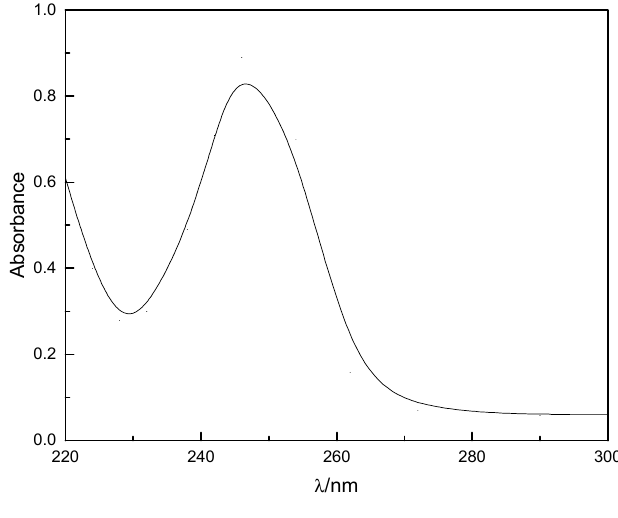
Figure 1. UV spectroscopy of IPETC.